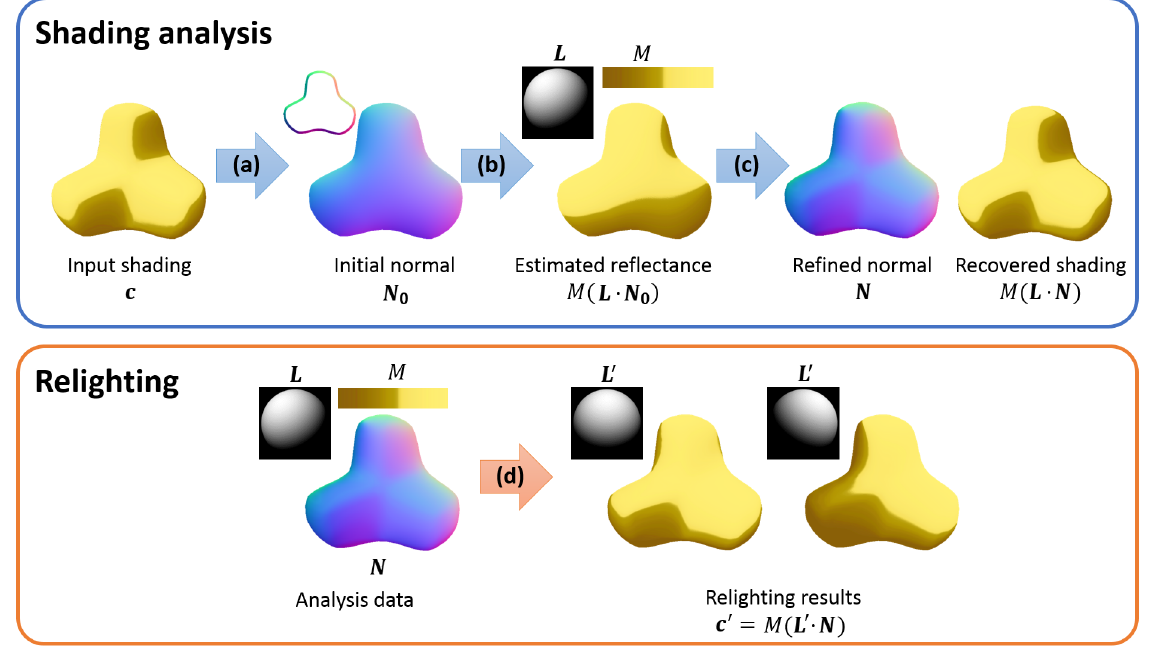
Fig. 3 Method overview. (a) Initial normal estimation to approximate a smooth rounded normal field. (b) Reflectance estimation to obtain a light and a color map. (c) Normal refinement to modify the initial normal by fitting the shading appearance. (d) Relighting to provide lighting interactions based on the shading analysis